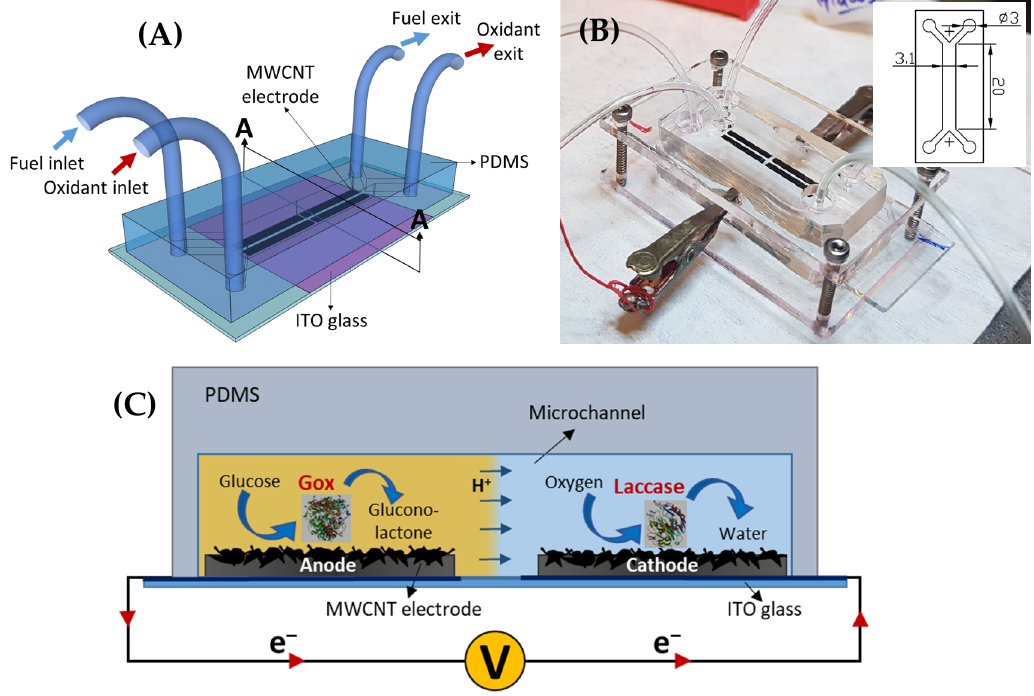
Figure 1. A schematic ( A ) and optical ( B ) image of the membraneless, microfluidic enzymatic biofuel cell (EBFC) (Inset shows microchannel dimensions in mm). ( C ) Schematic presentation of cross-section (A–A) illustrating the biosensing mechanism of the microfluidic EBFC.